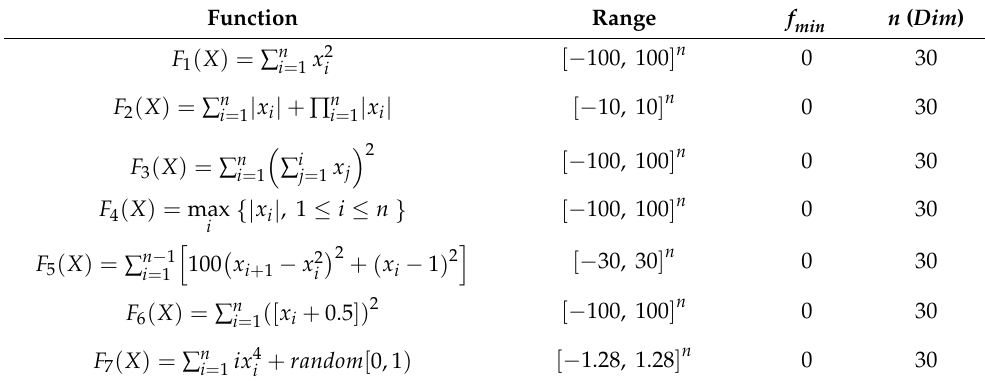
Table 3. Unimodal benchmark functions.